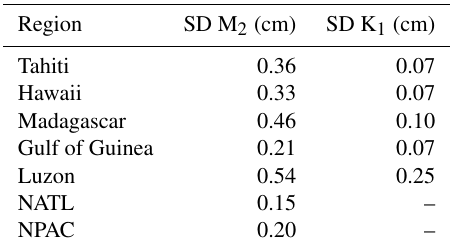
Table 2. Spatial-mean SD (cm) of the M 2 and K 1 IT models for each studied